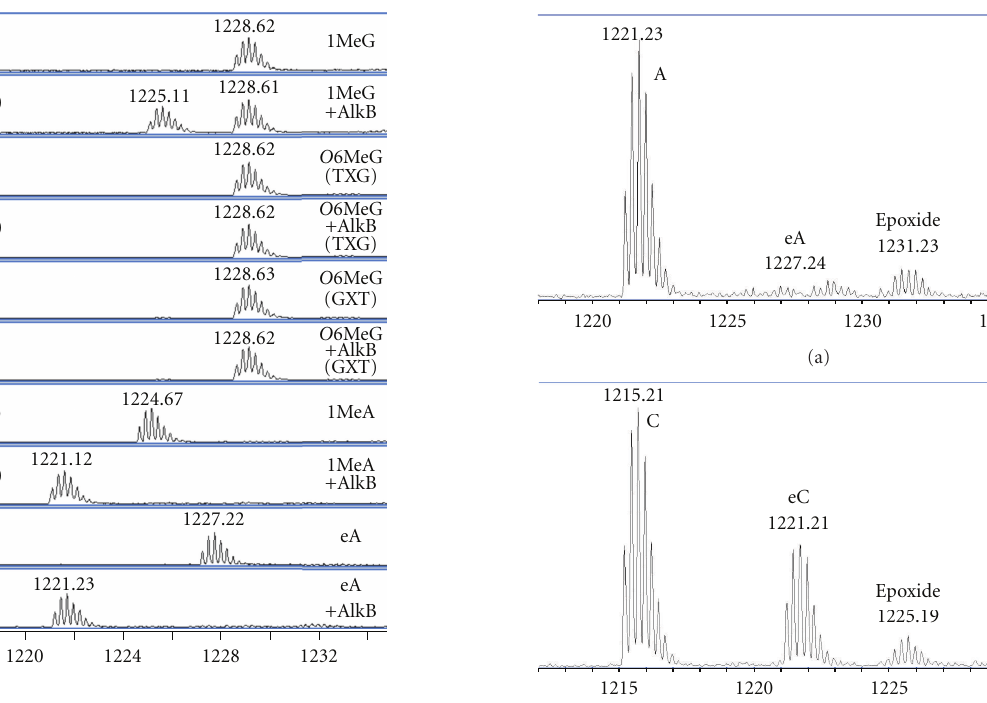
Figure 3: ESI-TOF analysis of 16mer reactants and products from the in vitro incubation reactions of alkylated lesions and AlkB protein. Data represent the − 4 charge envelopes; multiple ion mass peaks associated with each envelope reflect mostly the number of 13 C atoms in each − 4 charged packet. The monoisotopic peak (all 12 C, 14 N, etc.) value is labeled above each peak envelope. (a) 1MeG;